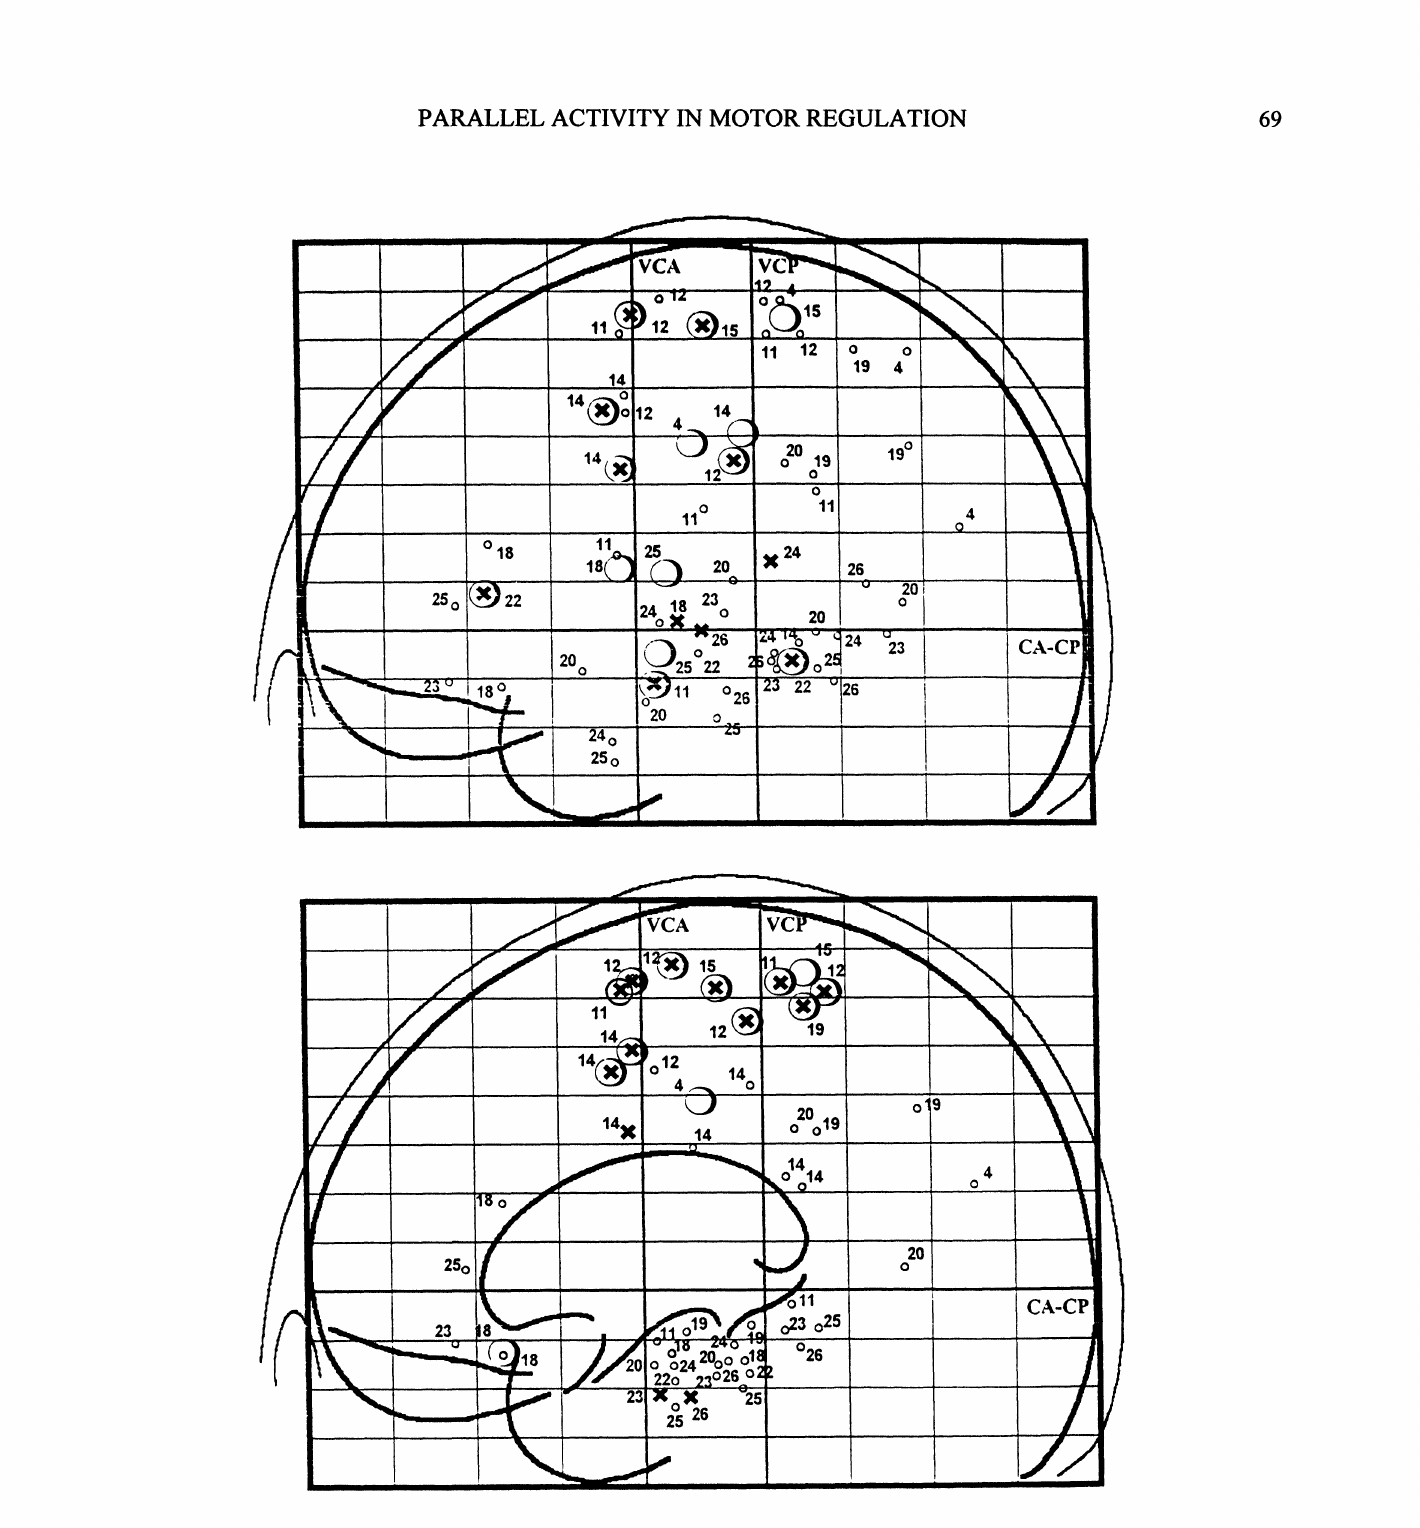
Fig. 3: Cortical recording sites in the Contingent Negative Variation Paradigm. Upper part: Lateral view of the brain. Lower part: Sagittal aspect. In the supracallosal part, the internal contacts of multilead electrodes mostly reached the mesial wall. In the lower part of the diagram, some recording points correspond to sites located more laterally. This schema presents the results in one or in both hemispheres. The numbers correspond to individual patients. The large circles show the MASP occurrence. The circles are crossed if CNV preceded MASP. The small circles indicate electrodes that recorded no slow potential. The non-circled crosses represent sites with CNV, but with no movement-accompanying slow potential. Reprinted from: Rektor I. et al. Electroencephalogr clin Neurophysiol, 1998; 107: 277-286, with permission from Elsevier